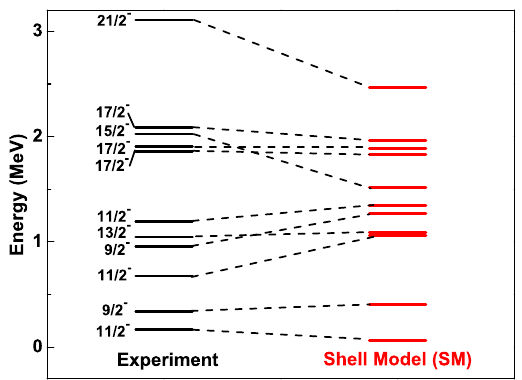
Figure 6. Comparison of the calculated energy levels (red) using shell model calculations with the experimental levels